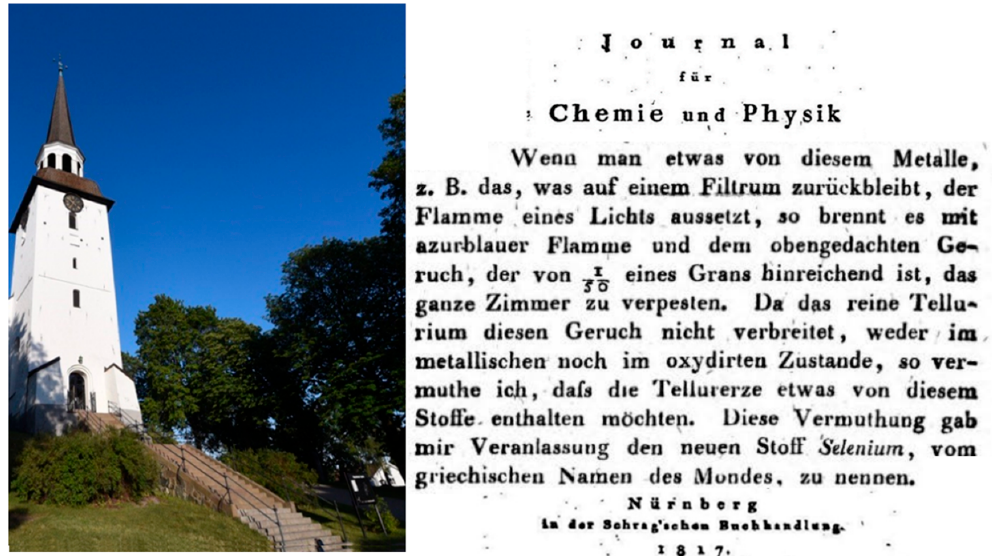
Figure 2. The discovery of selenium. The picture to the left shows Gripsholm village, where Berzelius, in 1817, saw the red mud in the lead chambers of a sulfuric acid factory, which is hidden behind the church. This mud turned out to contain selenium. The little white hut below the trees (right lower corner) was the laboratory of Berzelius (picture taken by L. F. on occasion of the selenium meeting “Se 2017” in Stockholm, organized by Elias Arnér at the Karolinska Institute). The right panel shows an excerpt of the letter of Berzelius to the editor of the Journal für Chemie und Physik , J. S. C. Schweigger, in which he reports on the discovery of selenium for the first time. The letter is dated January 27, 1818, but published in a volume of 1817 [59].